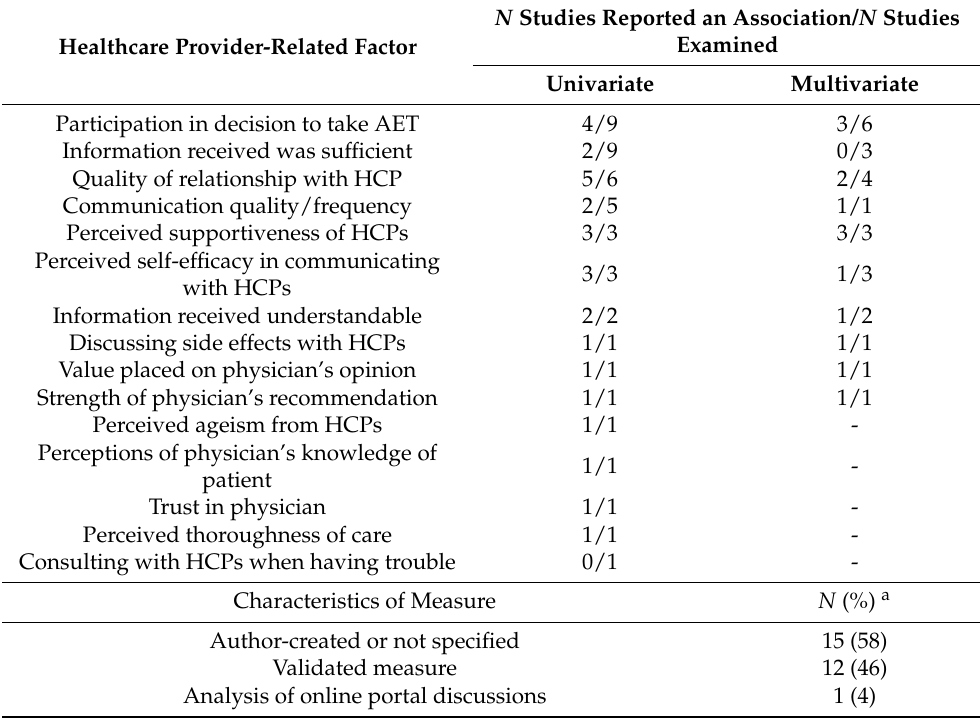
Table 6. Characteristics of studies that measured healthcare provider-related factors ( N =